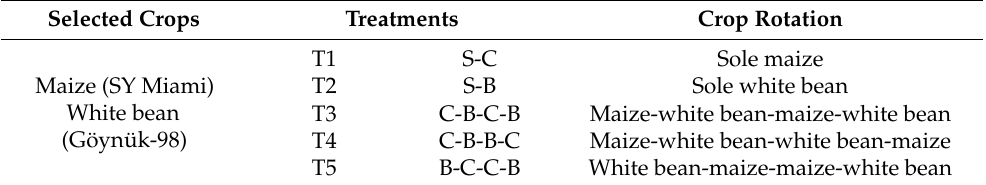
Different sowing systems and treatments adopted in the study area of Nur Sultan,